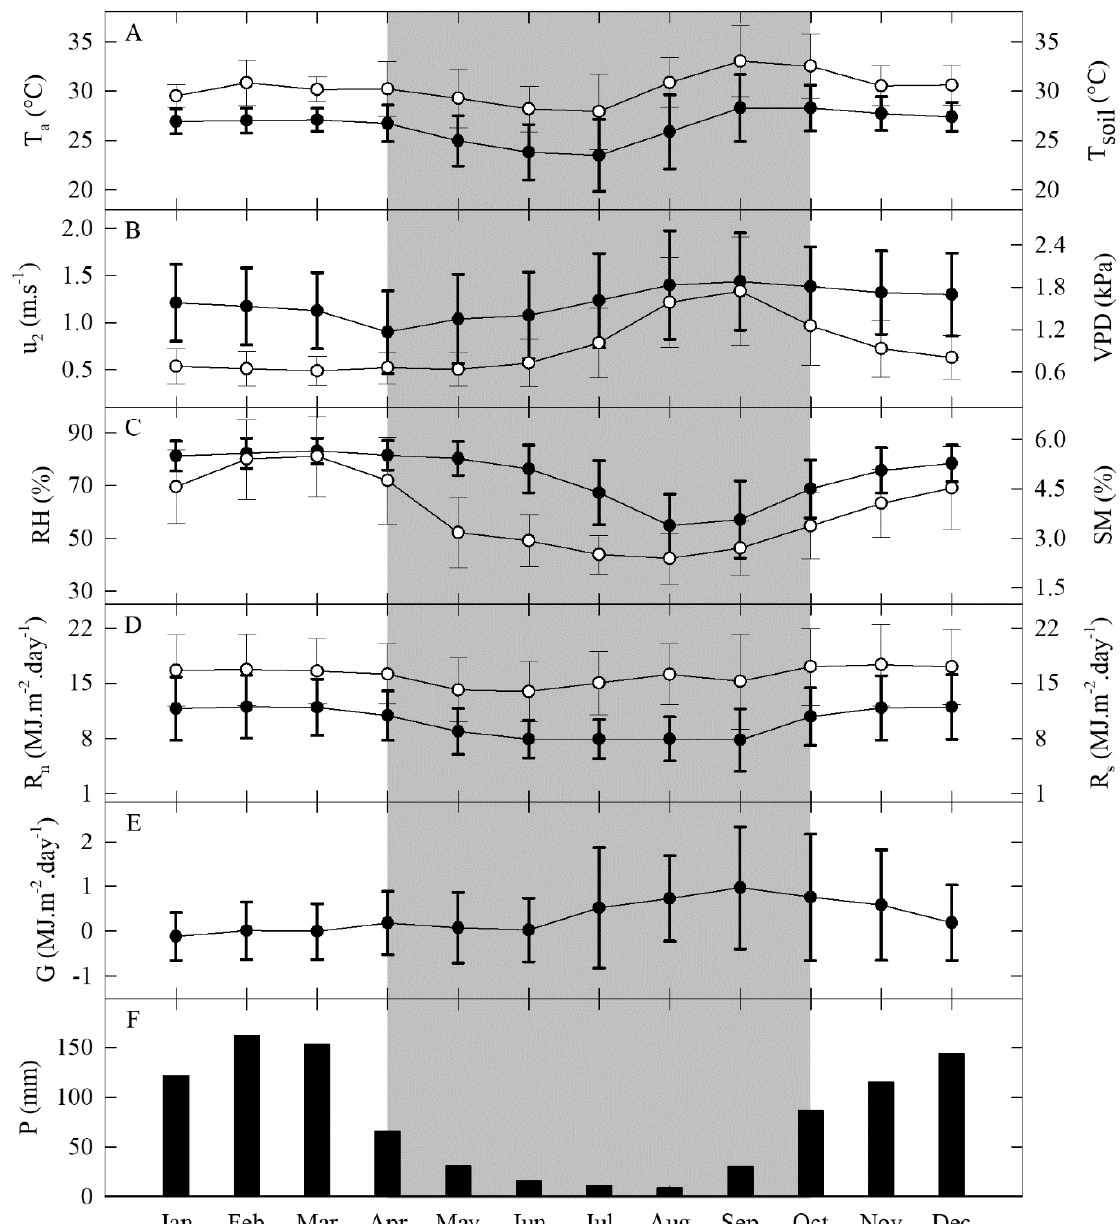
Figure 2. Mean monthly micrometeorological measurements of ( A ) air temperature (black circles, left-hand axis) and surface soil temperature (white circles, right-hand axis); ( B ) wind speed at 2 m height (black circles, left-hand axis) and vapor-pressure deficit (white circles, right-hand axis); ( C ) relative air humidity (black circles, left-hand axis) and surface soil moisture (white circles, right-hand axis); and ( D ) net radiation (black circles, left-hand axis) and solar radiation (white circles, right-hand axis); ( E ) soil heat flux; and ( F ) total monthly precipitation. The whiskers indicate the range within the standard deviation. The shadowed area indicates the dry season.